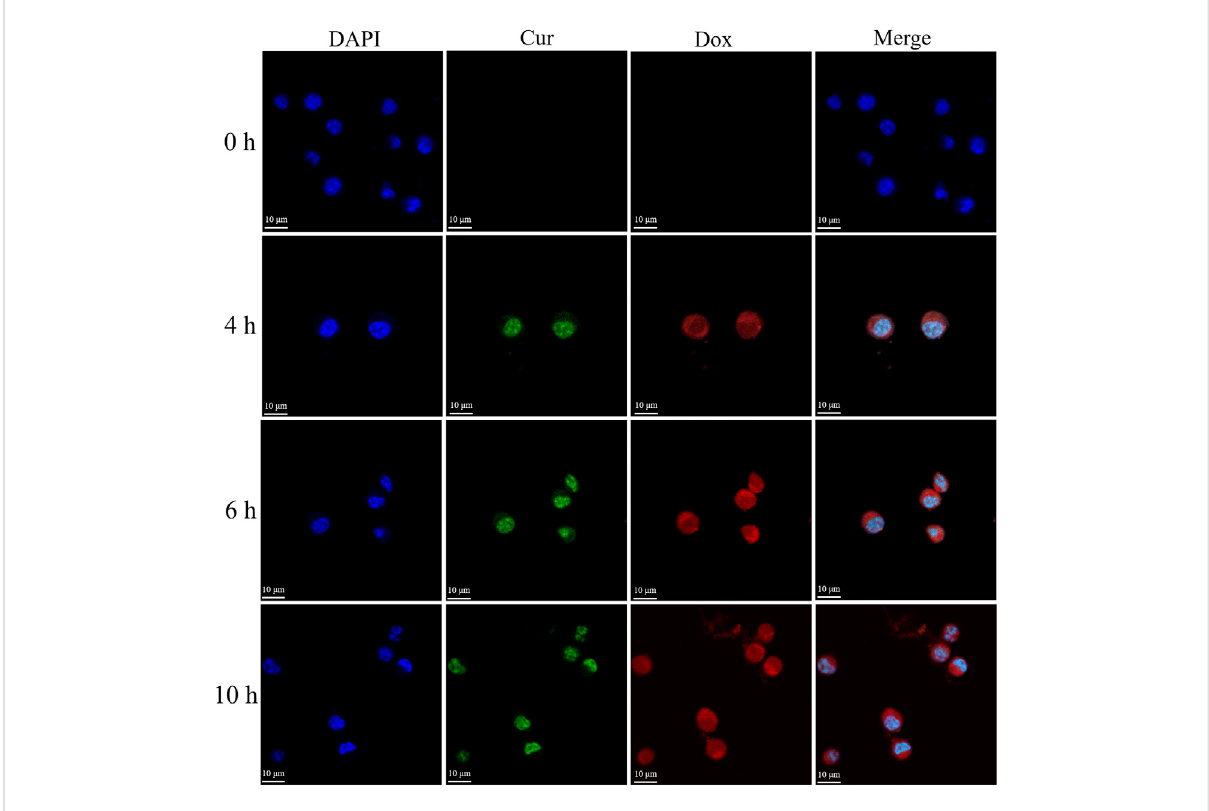
FIGURE 10 Laser scanning confocal microscopy (LSCM) images of MCF-7